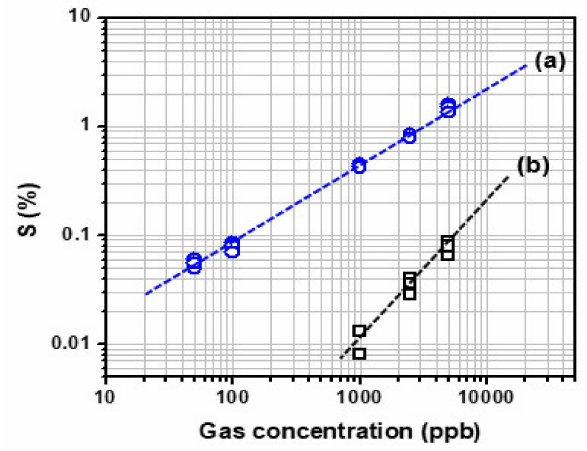
Figure 5. The sensitivity of the ( a ) C8F-doped-PPy/PLA 0.5 @SWCNT sensor and ( b ) C8F-doped- PPy/PLA 0.0 @SWCNT sensor observed by exposure to 50–5000 ppb of C 3 H 6 O